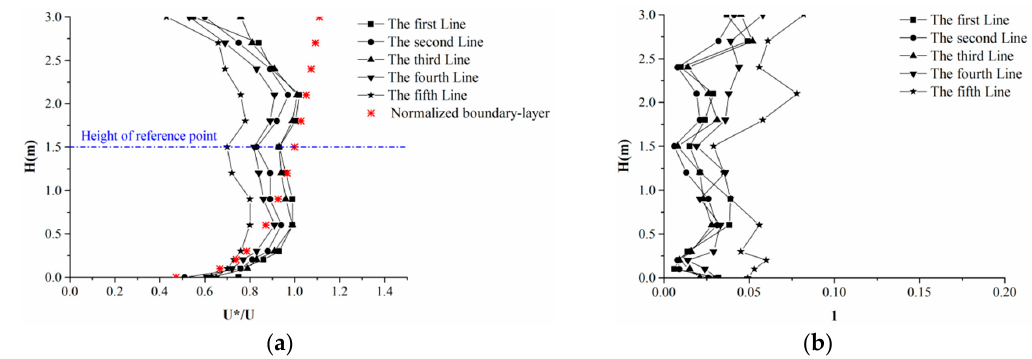
Figure 6. Wind field on the section which is 4 m away from the outlet: ( a ) mean wind and ( b ) turbulence intensity.